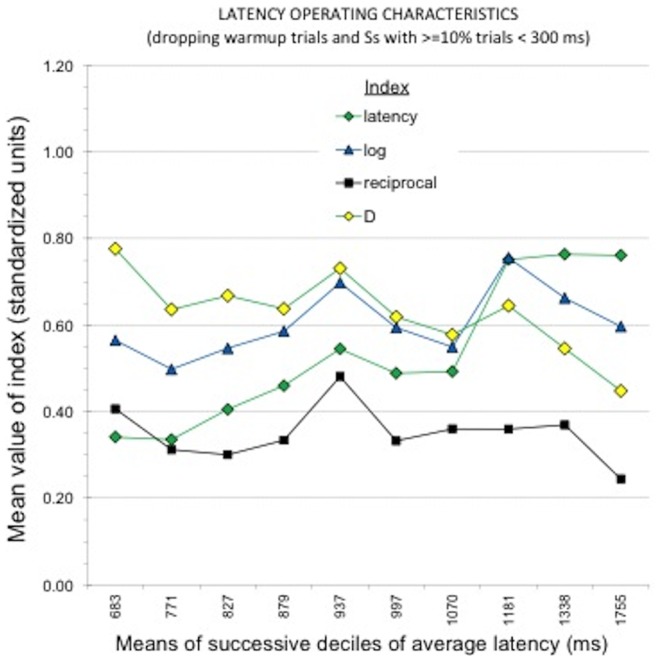
Latency operating characteristics, showing variation in mean standardized values of the five candidate BIAT scoring algorithms across deciles of the sample's distribution of average speed of responding for the political BIAT.For this plot, the algorithms were computed after deleting 4 warm-up trials from each response block and also deleting latencies greater than 10,000 ms. There were 202 or 203 respondents in each decile. Most noticeable in the graph is the inferior performance (smaller effect sizes) for the reciprocal measure, and strongest performance for the D measure. Also noticeable is that the D measure was smallest for the slowest subjects, whereas the log and latency measures were largest for the slowest subjects.